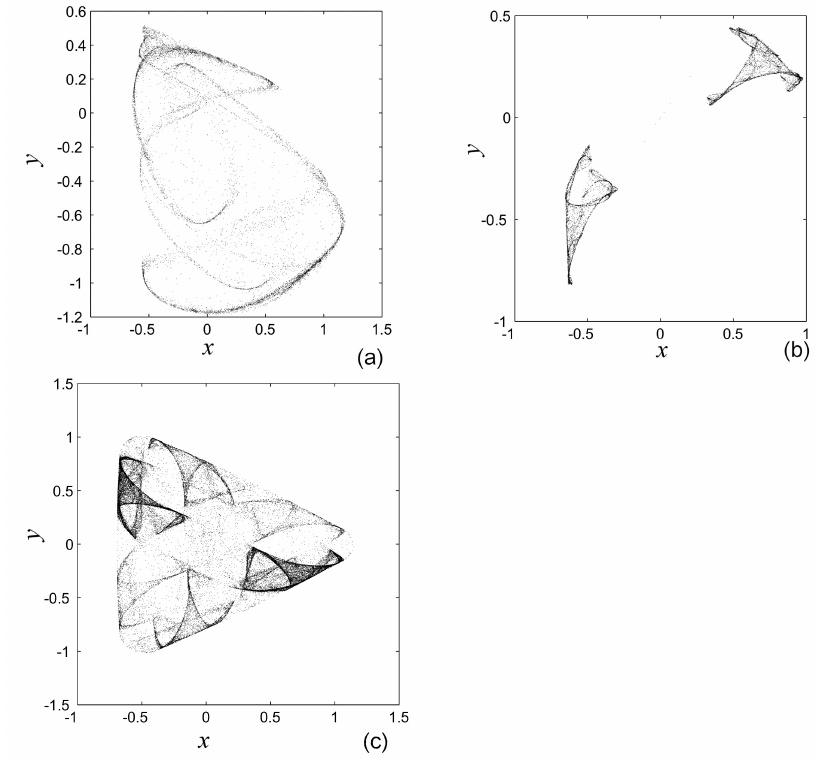
Figure 9. Hidden chaotic attractors of the DLMFO with broken-symmetry. ( a ) q = 0.03 and [ x 0 , y 0 ] 5 = [ 0.1, − 0.7 ] . ( b ) q = 0.03 and [ x